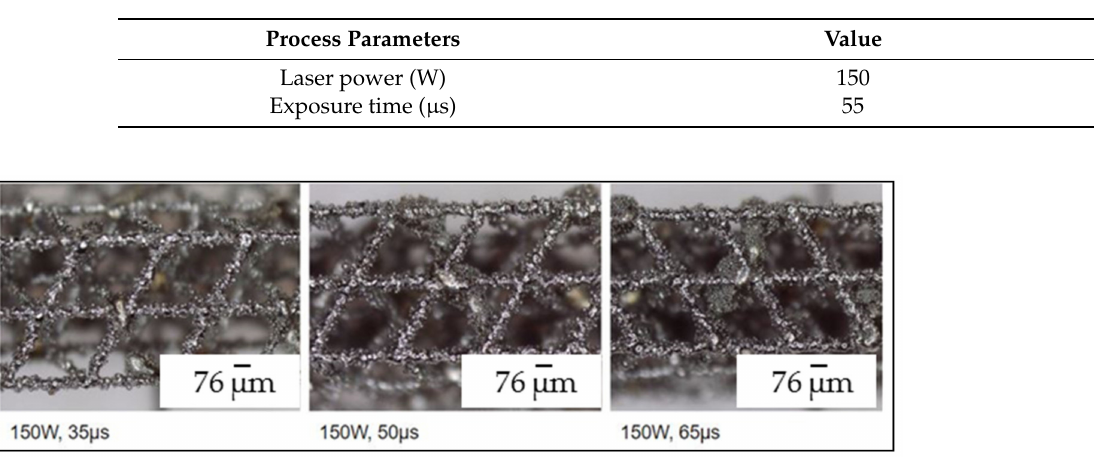
Table 4. Optimized process parameters used for the L-PBF process.